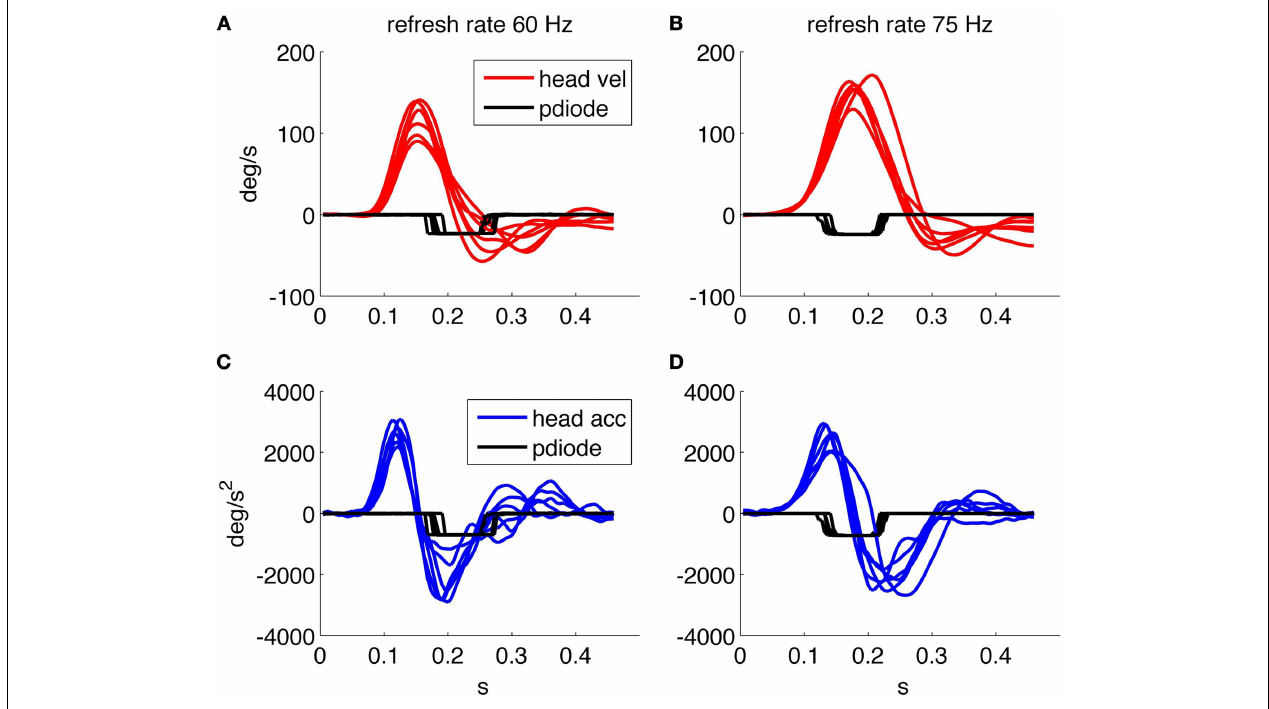
FIGURE 2 |Timing performance of the system using a screen running at 60Hz . (A) Head velocity/sensor output. (C) Head acceleration/sensor output and one running at 75Hz. (B) Head velocity/sensor output. (D)